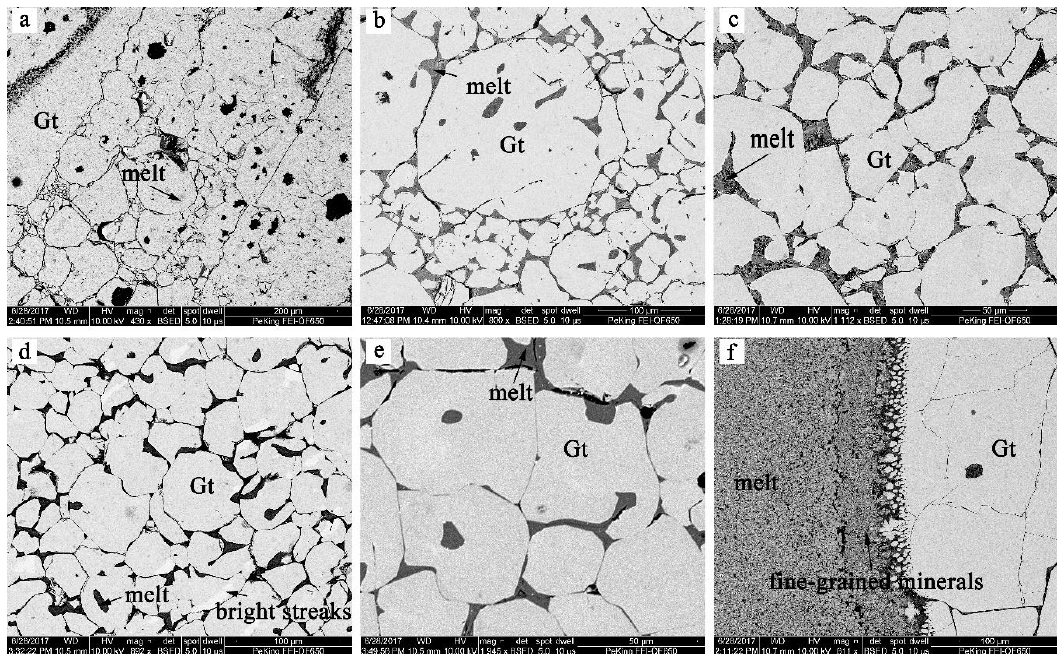
Figure 1. Electron backscattered images showing the textures of the synthesized samples: ( a ) LMD611, ( b ) LMD618, ( c ) LMD622, ( d ) LMD631, ( e ) LMD613, and ( f ) LMD625. Garnet (Gt) and melts are